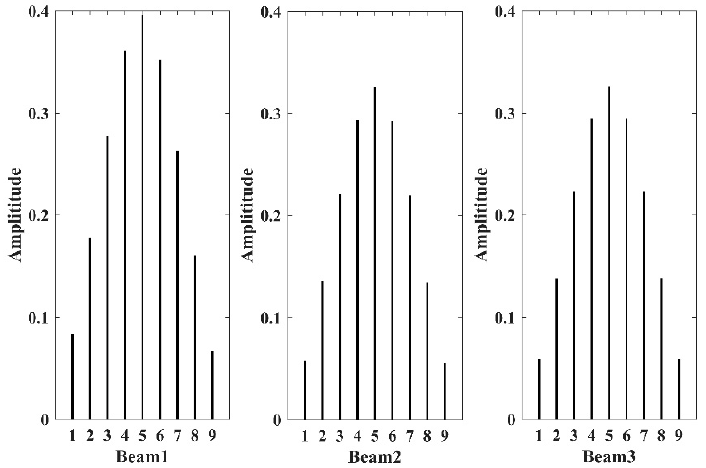
Figure 11. The amplitudes of frequency domain responses of the LRRB measured by different sensors